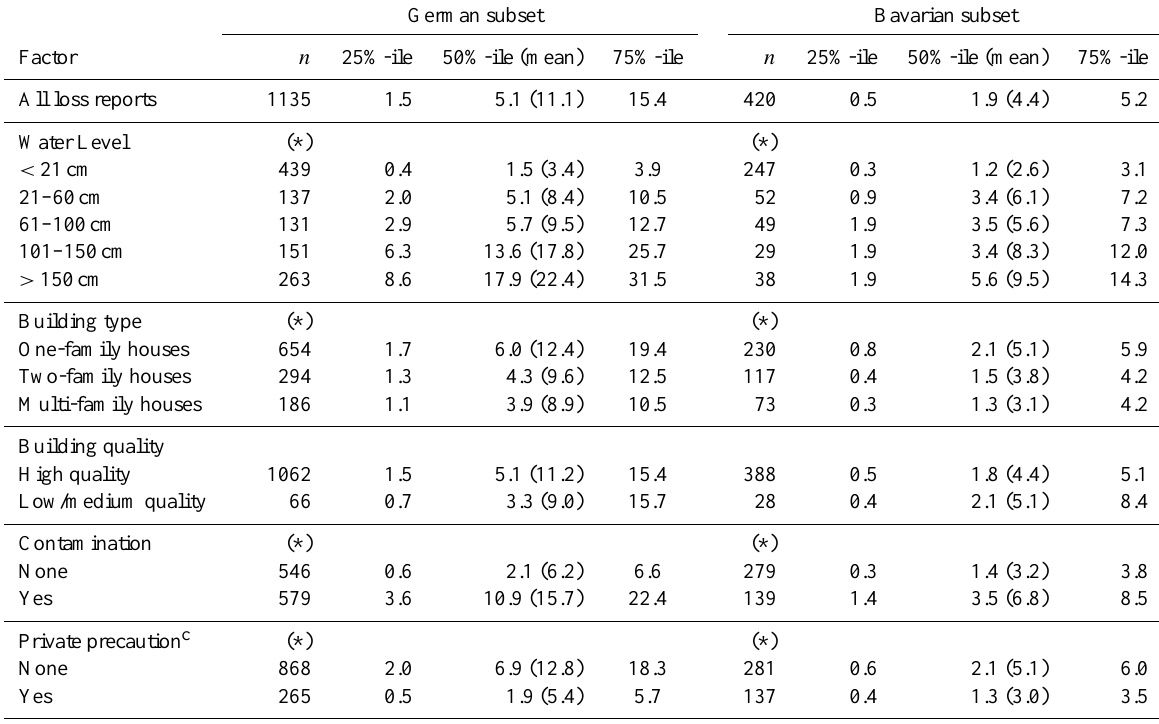
Table 2. Statistical characteristics of the flood damage ratios of the German-wide subset a and the Bavarian subset b , differentiated between the factors considered in the extended/adapted flood loss